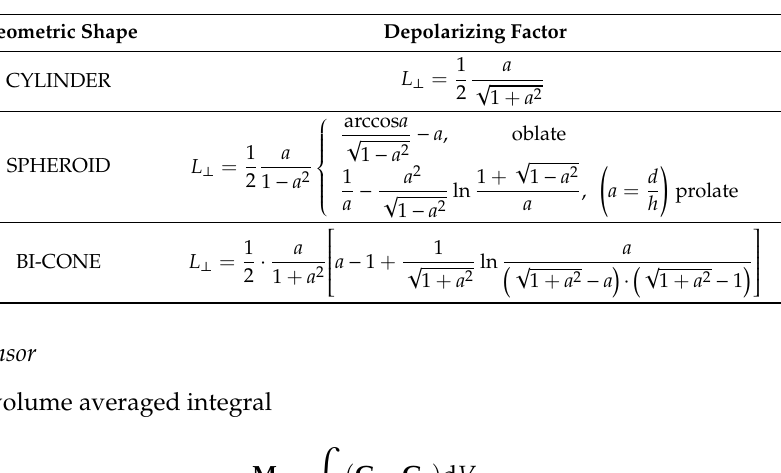
Table 1. Depolarizing factors dependence on the geometric shape of nanoparticles.